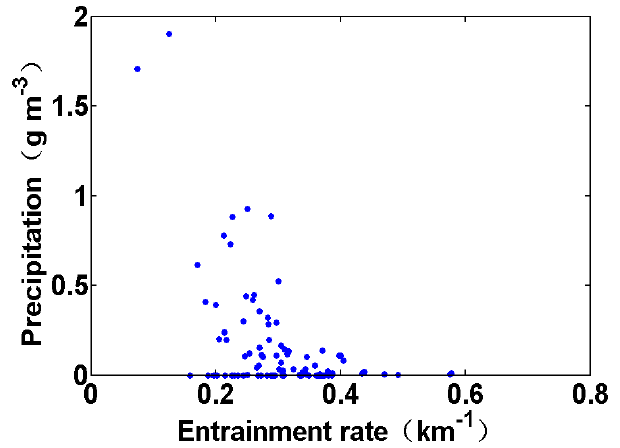
Figure 6. Scatter plots of entrainment rate vs.